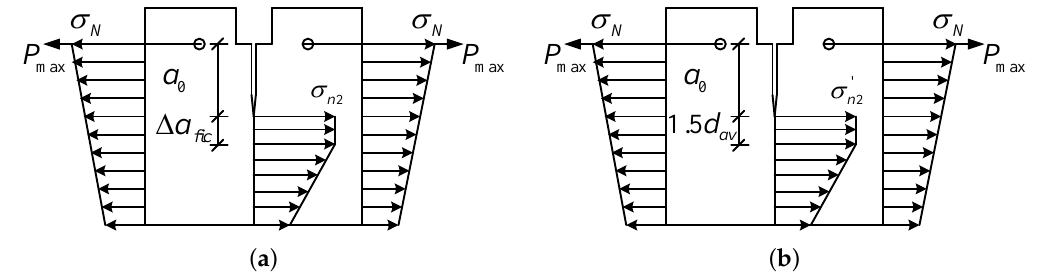
Figure 2. The definition of two nominal stresses in ( a ) Hu-Guan’s boundary effect model and ( b ) Hu-Zhang’s boundary effect